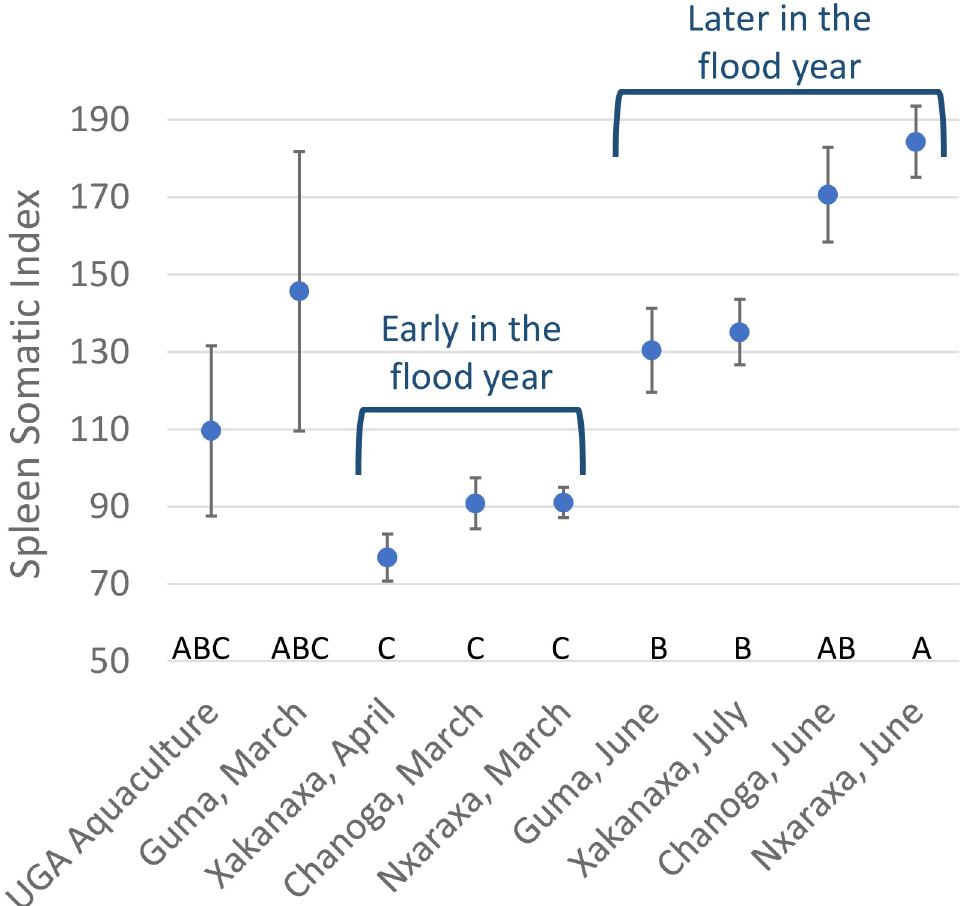
Fig 6. Mean (+/- 1 SE) spleen-somatic index (SSI) was elevated in fish collected later in the flood season, compared with fish collected earlier in the year, before hypoxic conditions began. Data suggest that hypoxic exposure is associated with splenomegaly, as is expected during hypoxia-induced polycythemia. SSI = ((spleen weight (mg)/fish weight (g)) � 100). Collections not connected by the same letter at the bottom of the graph are significantly different, based on one-way Welch’s analysis of variance (p < 0.0001) for samples with unequal variance, followed by Games- Howell post-hoc comparisons. the five control samples from UGA Aquaculture-raised Oreochromis niloticus - aureus hybrids. But, granulocyte numbers escalate, along with lymphocytes and macrophages, when fish are challenged by pathogens, parasites, contaminants, or hypoxia [21–23]. Hence, in the Okavango fish, we observed profuse aggregations of mast cells and granulocytes, both intact and degranu- lating, surrounding most or all acinar cell clusters (Figs 7 and 8A). Interestingly, the hematoxylin and eosin staining characteristics of granulocytes varied by genus in this study (Fig 7). In threespot and greenhead tilapia, most granulocytes were baso- philic and abundant, although small numbers of eosinophilic granulocytes with blue or pink granules and double lobed nuclei (neutrophils) were also sometimes observed. In redbreast tilapia, granulocytes were usually eosinophilic and more moderate in number, although 10% of sampled redbreast tilapia exhibited basophilic granulocytes with occasional eosinophilic nuclei. In fishes, leukocyte staining characteristics have been established to vary by genus and their influx is frequently associated with chronic inflammation [15, 16].